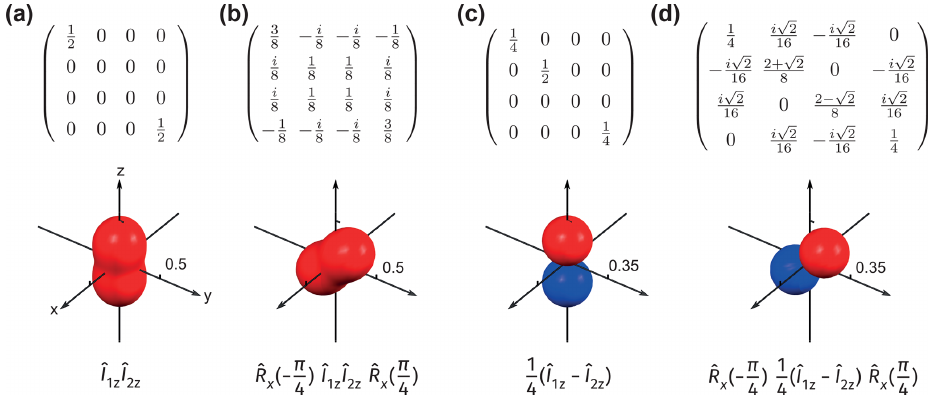
Figure 3. The density operators written in Zeeman basis {| αα (cid:105) , | αβ (cid:105) , | βα (cid:105) and | ββ (cid:105)} (top) and their visualizations (bottom) for (a) ˆ ρ = ˆ I 1 1 + ˆ I 1 z 2 z , (b) the same density operator as in panel (a) rotated by 4 operator as in panel (c) rotated by − π around ˆ x . Note that the surfaces in panels (a) – (b) and panels (c) – (d) are plotted using the measurement 4 (cid:16) (cid:17) (1 , 0) operators ( | 1 , 1 (cid:105)(cid:104) 1 , 1 | ) ˆ n and , respectively. The rotation is apparent by looking at the plotted surface, while it is hard to understand (cid:99) ZQ 0 , 0 ˆ n directly from the matrix form of the density operator.